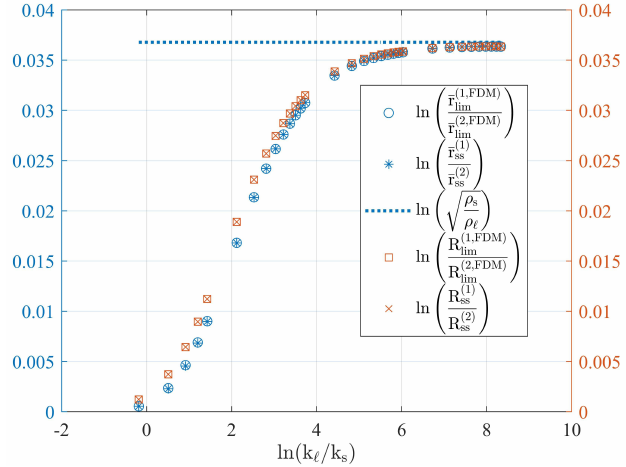
Figure 2. Logarithmic relation between the two mass-accommodation methods previously dis- (cid:0) (cid:1) (cid:0) (cid:1) r ( 1 ) / r ( 2 ) R ( 1 ) / R ( 2 ) cussed ln and ln , obtained from the exact steady-state solutions given through Equations (21) and (22), and the asymptotic time values estimated through the FDM. Asterisk and cross symbols are used to represent the relation obtained through the exact steady-state values. Empty circles and squares represent the relation between the asymptotic time limits according to the numerical solutions for each mass-accommodation method. The dashed line corresponds to the predicted relation for high melting fractions according to Equation